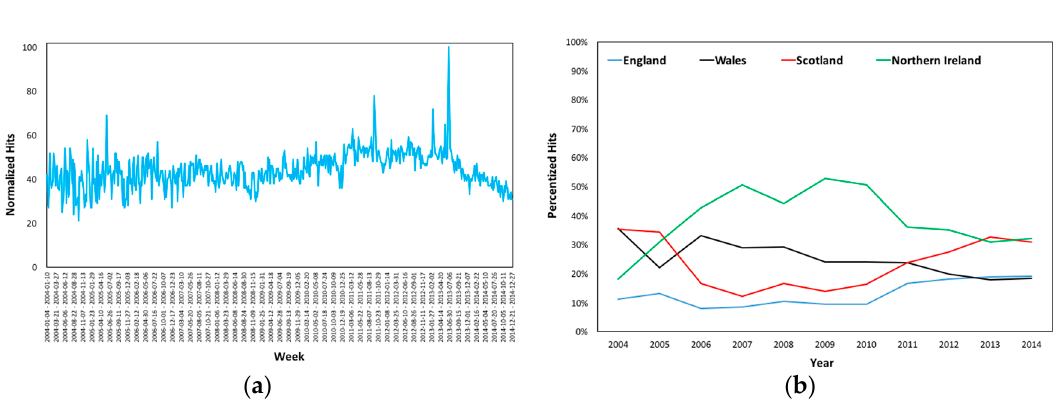
Figure 3. Diclofenac’s ( a ) Normalized Hits in the UK and ( b ) Regional Percentized Hits Averages 2004–2014.